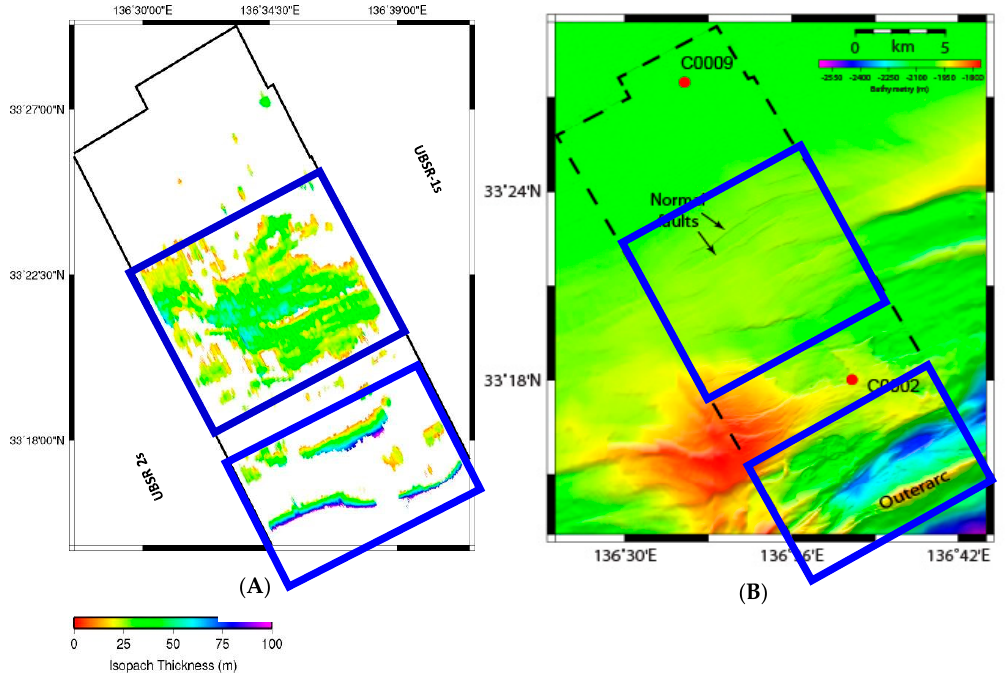
Figure 5. ( A ) Distribution of Upper BSRs. The isopach thicknesses range from 10–100 m with an average value of 40 m. This thickness map is the thickness of hydrate concentration zones; ( B ) Bathymetric map of the study zone for reference.